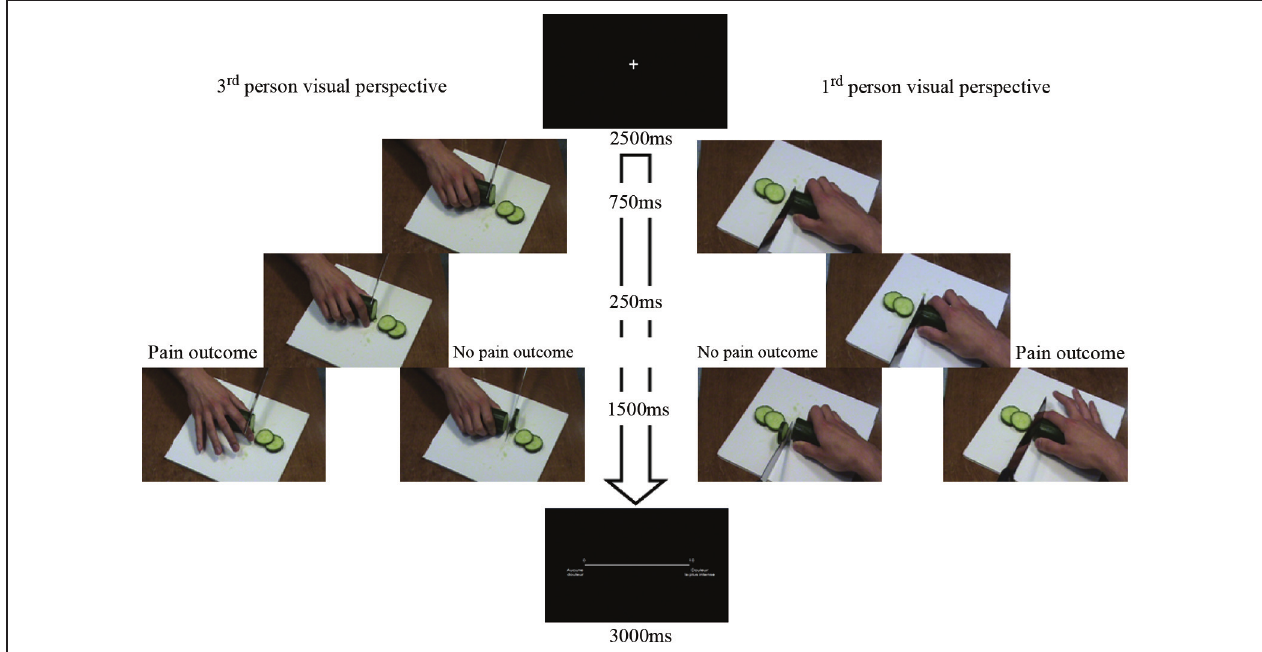
FIGURE 1 | Illustration of the task design: sequences of three pictures showing painful or nonpainful scenarios were displayed in a first (1PP arm at 0–45 ◦ angle; right-hand side of the figure) or third person visual perspective (3PP: arm at ∼ 180 ◦ angle; left-hand side of the figure) . Visual stimuli were presented in sequence with variable timing